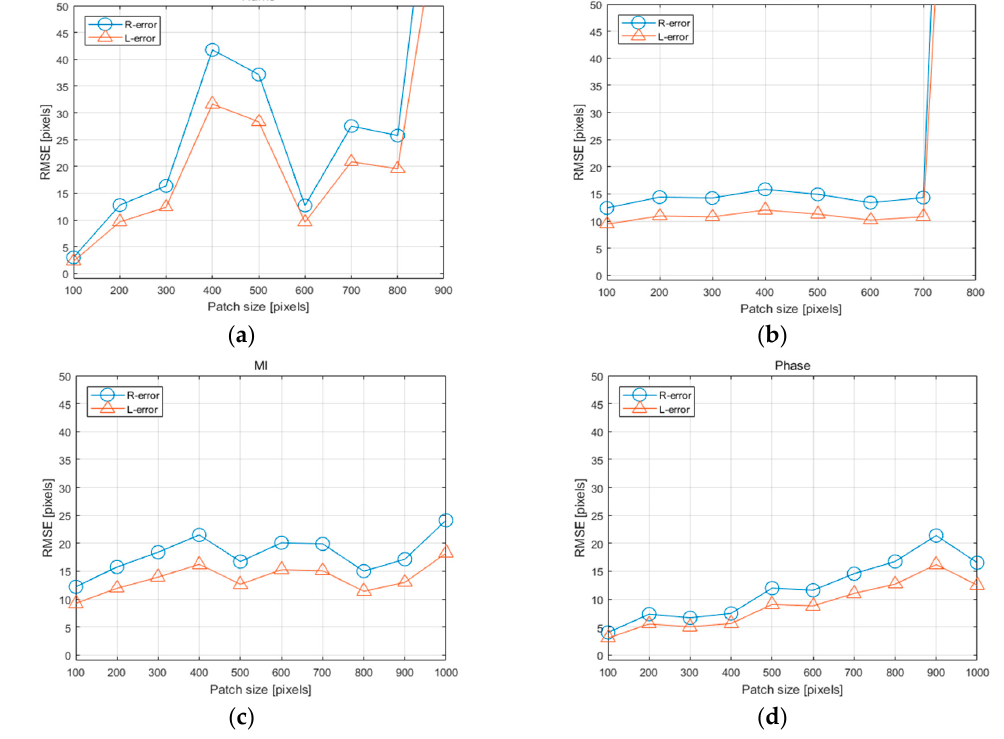
Figure 16. Reprojection errors (across-track Kompsat-3A original—before adjustment): ( a ) HARRIS– FREAK ( b ) SURF, ( c ) MI, and ( d )